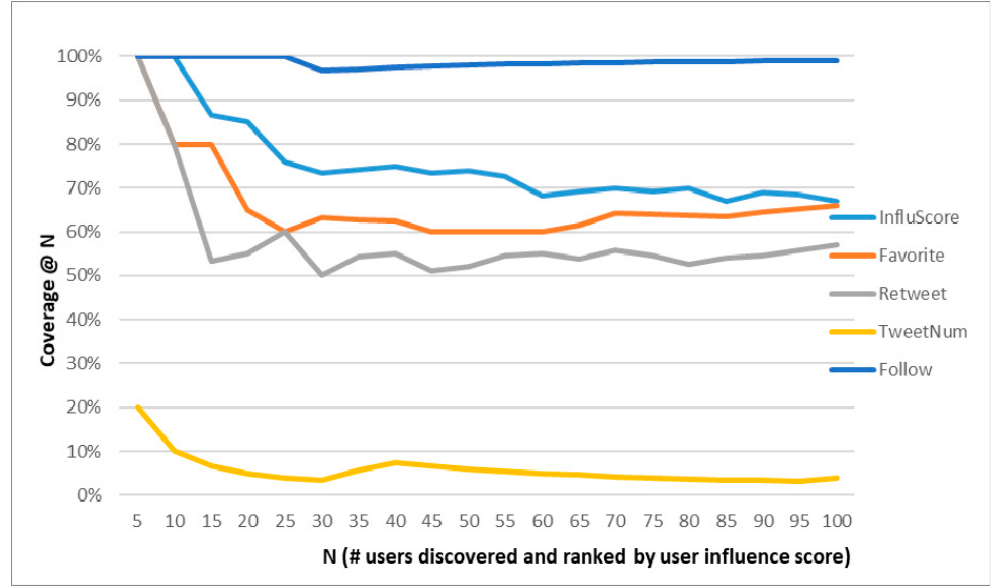
Figure 7. The effects of different types of interactions on the coverage rates. Figure 7. The e ff ects of di ff erent types of interactions on the coverage